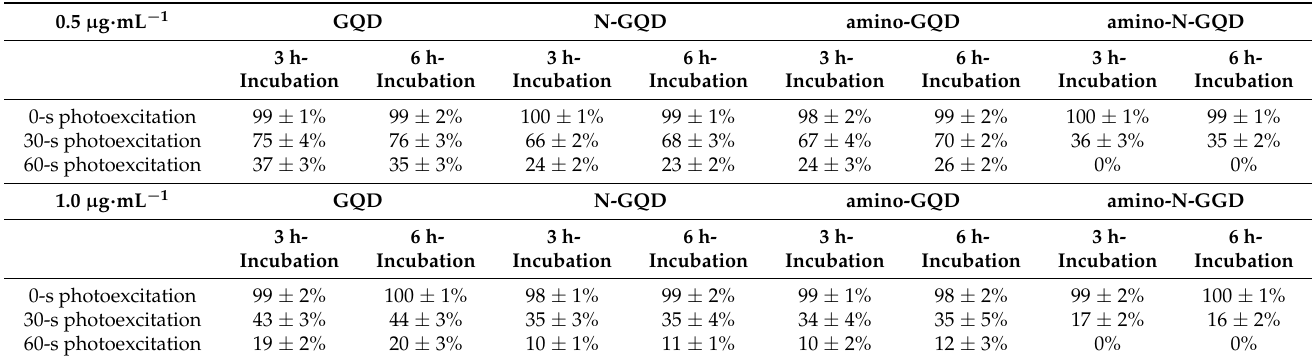
Figure 4. ( a ) Low-magnified TEM image; ( b ) HR-TEM image of a single GQD exhibiting the graphene {1 1 − 00} lattice plane (mean lateral size = 8.0 nm; d -spacing = 0.213 nm); the size distribution of its histogram was determined using DLS (Figure S1b). ( c ) XRD spectrum of GQDs, indicating a diffraction angle 2 θ of nearly 24.3° and revealing a well-ordered lamellar structure with favorable layer regularity and an interlayer distance of 0.360 nm. ( d ) UV-vis spectrum of GQDs. The peak at 211 nm corresponds to the π → π * transition of aromatic C=C bonds, whereas that at 312 nm corresponds to the n → π * transitions of the C=O shoulder. ( e ) Raman spectrum of GQDs. The gray and brown lines indicate the spectrum decomposed and fitted to D- and G-band peaks (at ~1383 and 1607 cm − 1 , respectively; black line: raw data; pink line: decomposed spectrum). The I D/ I G integrated intensity ratio was 0.89. The diameter obtained from the Raman calculations (Equations (S2) and (S3)) was approximately 7.8 nm. The estimated size almost matched that obtained from the HR-TEM calculations. ( f ) Deconvoluted C(1s) XPS spectra with Gaussian function-fitted peaks: nonoxygenated ring (C–C/C=C, 285.8 eV), hydroxyl (C–O, 286.9 eV), carbonyl (C=O, 288.1 eV), and carboxylate (O=C–O, 289.0 eV) groups. The table summarizes the bonding composition and atomic ratio of the GQDs. Delivered dose: from 0.5 µ g · mL − 1 to 5 mg · mL − 1 material. Table 1. MRSA viability (%), determined from the viable count of material–Ab protein A -treated MRSA obtained using the CFU assay under a short 670-nm laser excitation. Data are presented as mean ± SD ( n =